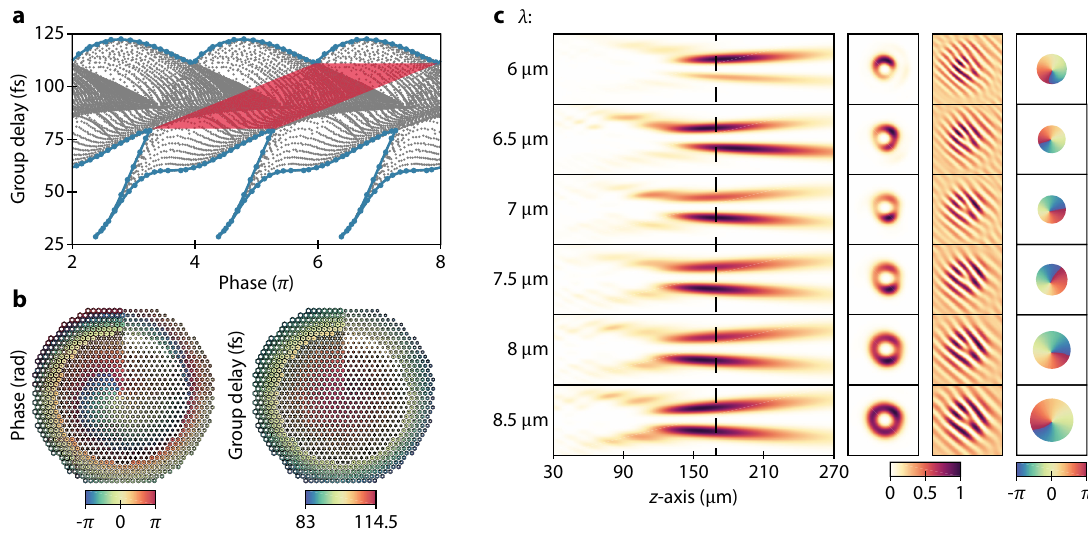
Figure 5: Framework for designing an achromatic metalens generating and focusing a vortex-beam. (a)Phaseandgroupdelayforallelementsinthepresentedlibrarydistinctivebythegreydots,withthebluelinesdefiningtheupperandlower boundaryofthelibrary,andtheredshadedareadisplayingthemaximalphaserangewhichthelibrarycancover.(b)Ametalensdesignedwith the vortex-beam focusing framework, carrying OAM l = − 1. The color overlays indicate the phase (left) and group delay (right) held by each element. (c) Simulated normalized intensity distributions of the designed metalens, its cross-section, interference pattern, and phase at the focal length of f = 165 μ